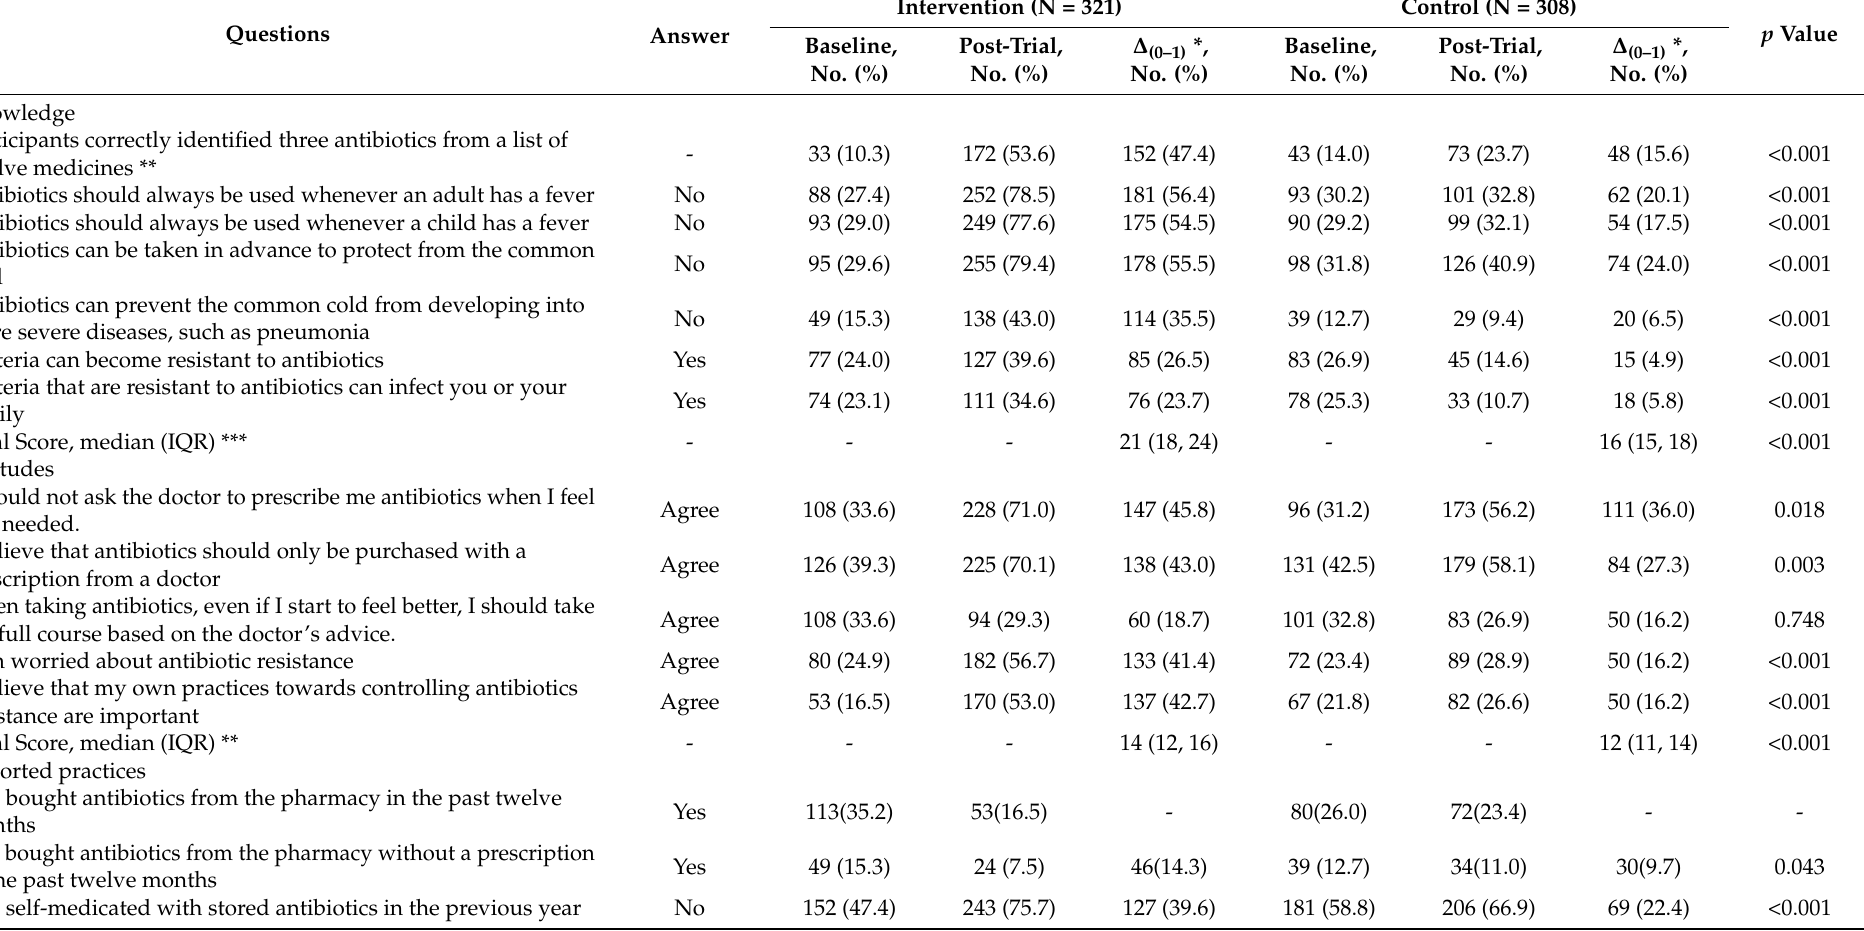
Table 2. Effect of intervention on knowledge, attitudes and reported practices on antibiotic use in